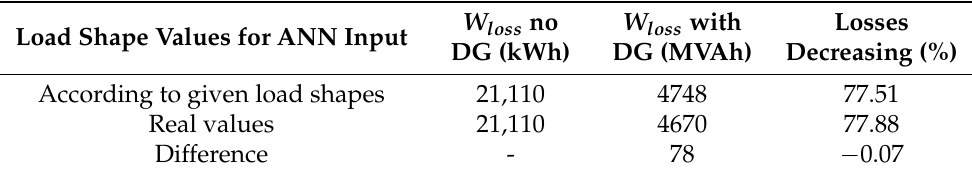
Table 13. Results of the proposed model application for 15 min input data for Opt 1 model— uncertainty of 20%.